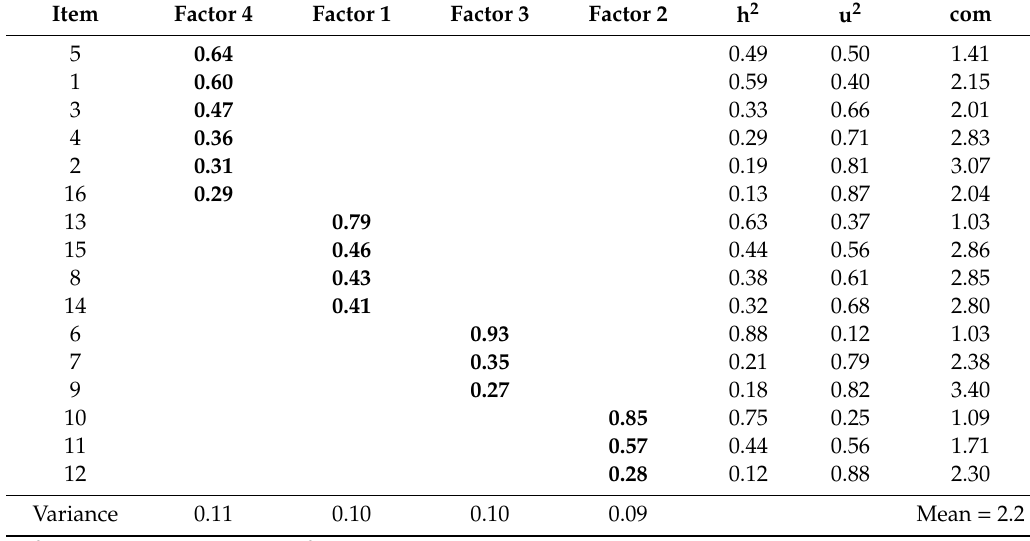
Table 3. Exploratory factor analysis (EFA) based on the polychoric matrix using principal axis and varimax rotation.